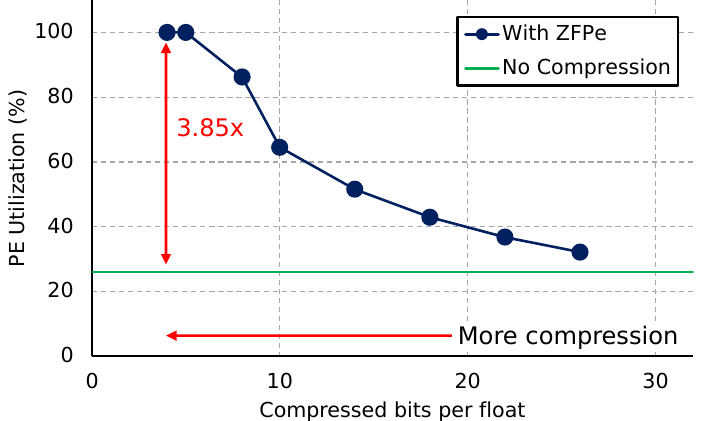
Figure 10. Performance impact of ZFPe acceleration, with smaller bit budgets to the